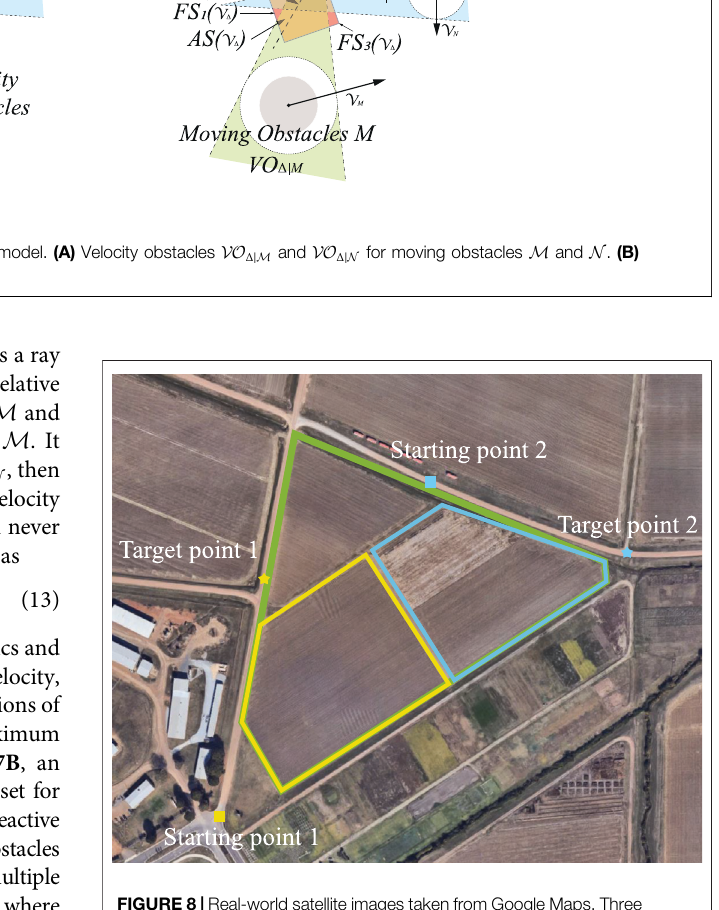
FIGURE 8 | Real-world satellite images taken from Google Maps. Three targeted areas with speci fi c starting and target points are assigned to CCPP (image from Mississippi State University North